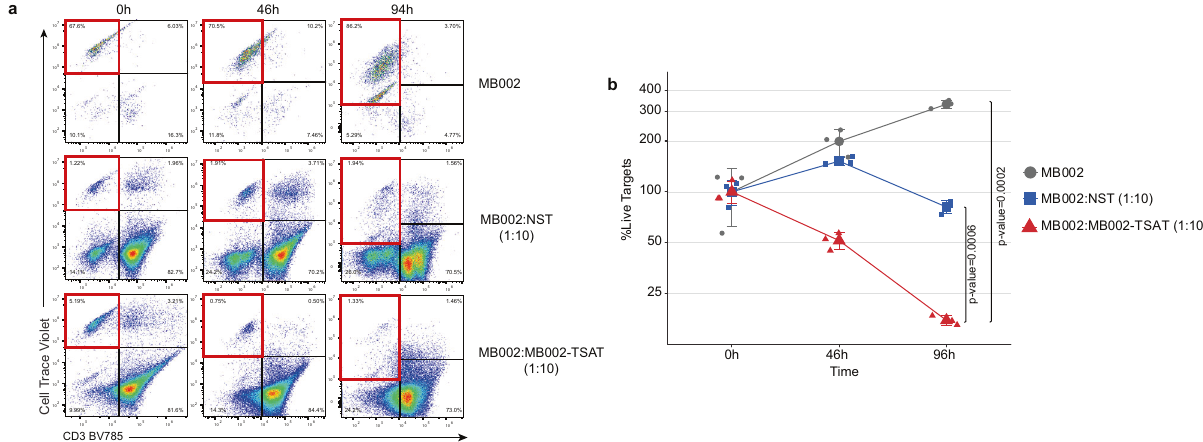
Fig. 6 MB002 TSA T cells speci fi cally lyse partially HLA-matched tumor cells. To assess cytotoxic function, cryopreserved TSA T were thawed and rested overnight prior to plating with tumor targets. At the indicated time points, co-cultures were harvested and acquired as described in the “ Methods ” . a Representative dot plots from one healthy donor showing proliferation of tumor targets in the absence of TSA T (top row), moderate reduction of tumor targets in the presence of non-speci fi cally activated T cells (PHA blasts; middle row), and robust lysis of tumor targets in the presence of TSA T (bottom row). Lysis was determined based on the disappearance of targets from quadrant 1 (red border). b Summary data of ( a ). NST non-speci fi c T cells (PHA blasts). One-way ANOVA p -values are shown. Values at each time point were normalized to 0 h (100%). One-sided ANOVA test was used to calculate the p -values, n = 3. p -values are indicated in the fi gure. Gating strategy for expanded TSA T tumor cell cytotoxicity assays shown in Supplementary Fig. 18. Data are presented as mean values + / − SD. Source data are provided as a Source Data fi